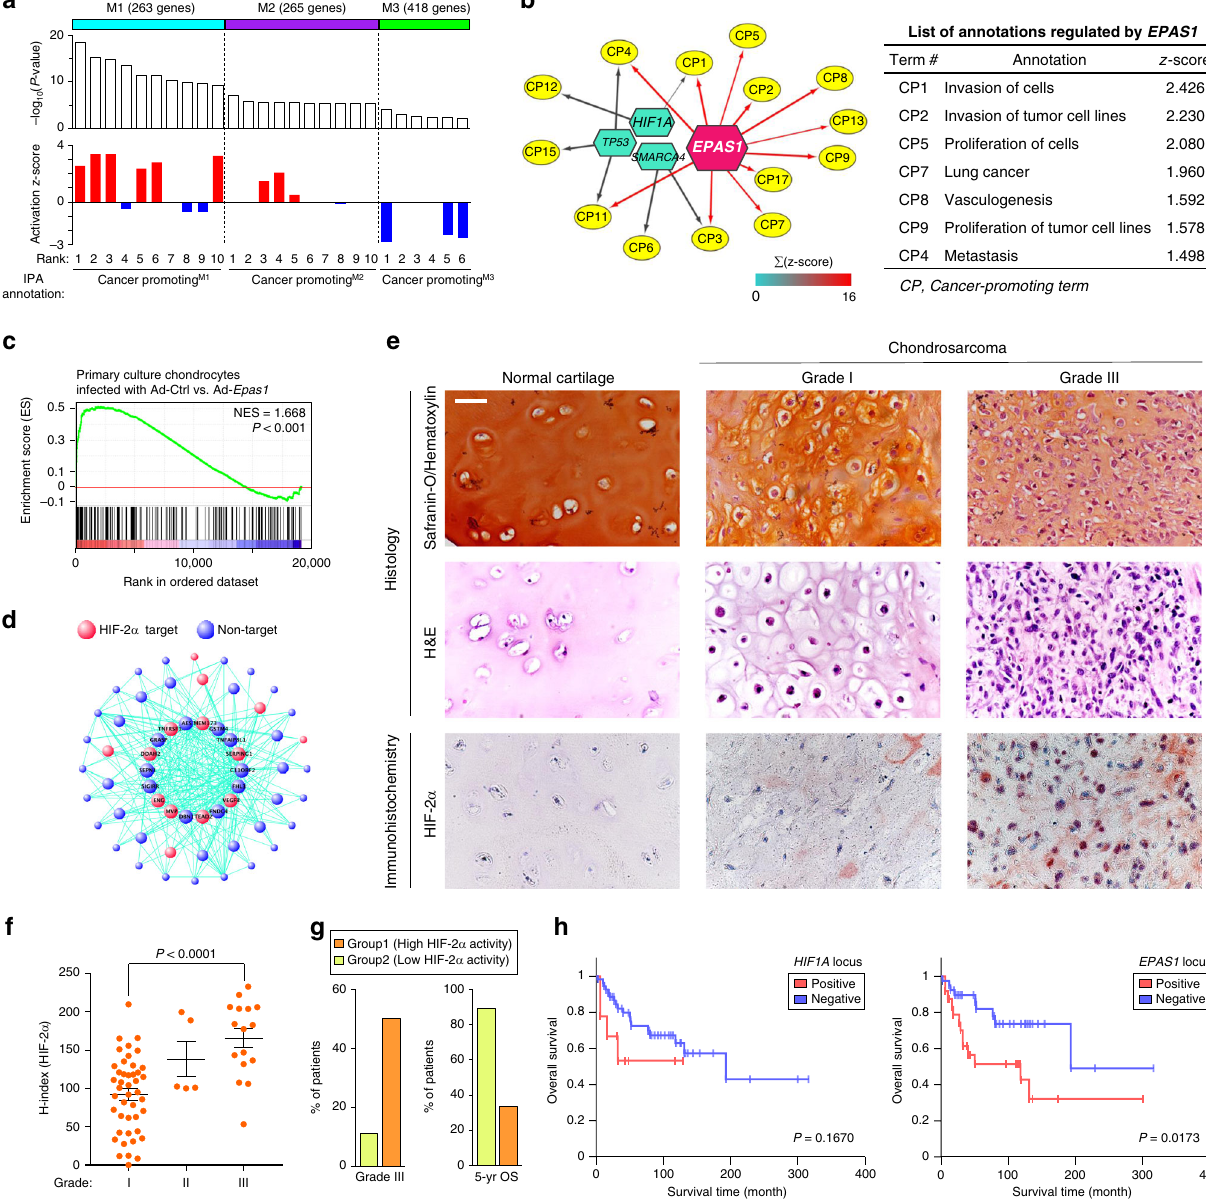
Fig. 1 HIF-2 α is an upstream regulator of gene module governing chondrosarcoma malignancy. a Three moderately sized modules identi fi ed by WGCNA using transcriptome data from chondrosarcoma patients (GSE12475). Cancer-promoting (CP) annotations, signi fi cantly associated with each module, were analyzed using IPA. For each module, top ten CP annotations were arranged in the order of – log 10 ( P -value). – log 10 ( P -value) > 2 was used as the cut-off value. A right-tailed Fisher ’ s exact test was used to determine the statistical signi fi cance. b The predicted upstream regulators of the M1 module were color-coded according to the sum of activation z-scores of linked nodes. Edges from EPAS1 are highlighted in red and their thickness indicates signi fi cance according to P -value against each annotation (left panel). Representative CP annotations, regulated by EPAS1 , were arranged in the order of activation z- score (right panel). A right-tailed Fisher ’ s exact test was used to determine the statistical signi fi cance. c GSEA was performed with the M1 module gene set using transcriptome data obtained from chondrocytes infected with adenovirus (Ad)- Epas1 compared to those infected with Ad-Control (Ctrl) (GSE73659). Normalized enrichment score (NES) and nominal P -value are indicated. d Network connections of M1 module genes visualized by VisANT. The hub genes are located toward the center of the network. e Representative histological and IHC images in normal human cartilage and chondrosarcoma biopsies. Scale bar: 50 μ m. f Quantitation of HIF-2 α expression in chondrosarcomas with different histological grades: grade I ( n = 44), grade II ( n = 5) and grade III ( n = 16). Signi fi cance was calculated by one-way ANOVA. Data represent mean ± SEM. g Patients were grouped by conducting k -means clustering based on collective expression pro fi les of canonical HIF-2 α target genes (Supplementary Fig. 1c). Clinical and prognostic features of patients in Group1 and Group2 are presented by their percentage in each group. 5-year OS; 5-year overall survival. h Kaplan – Meier plot of overall survival of the patients strati fi ed by ampli fi cation status of HIF1A (left panel; positive: n = 9; negative: n = 55) and EPAS1 (right panel; positive: n = 24; negative: n = 40) loci. Signi fi cance was calculated with the two-sided log-rank